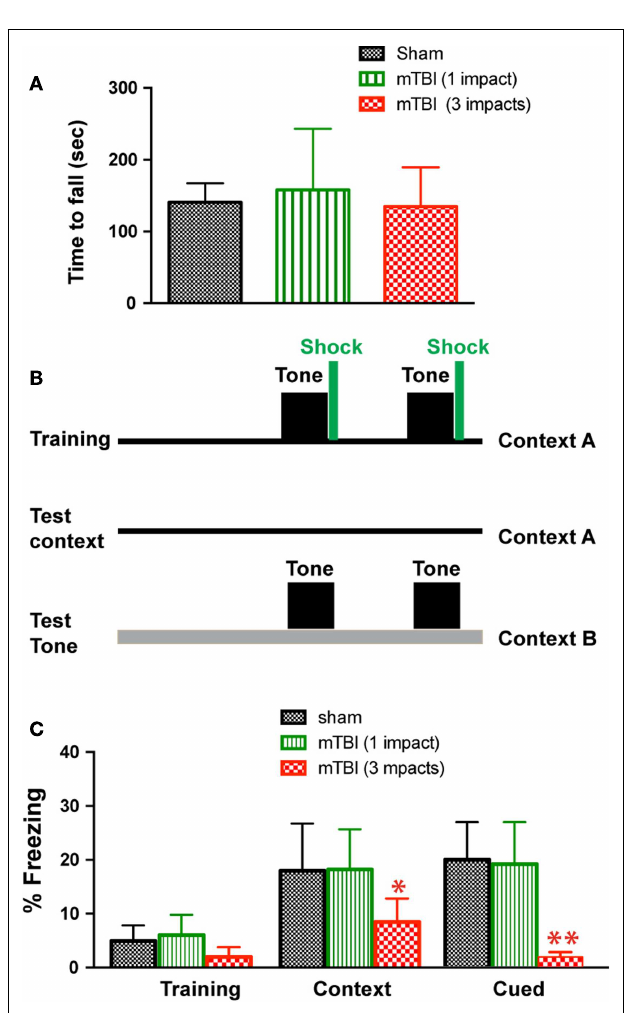
FIGURE 2 | Repetitive mTBI causes significant cognitive impairments 3months after injury .Three months after injury, the GFAP-luc mice shown in Figure 1E were tested for motor function using a Rota-Rod apparatus (A) and for learning and memory using fear conditioning (B,C) . (A) In the Rota-Rod test, latency to fall onto the transducer platform was automatically recorded.The average latency over the three trials was calculated for each mouse. No difference between the mTBI and sham groups were observed (mean ± SD, P > 0.05 by t test). (B) The test paradigm for fear conditioning. (C) The freezing behavior was recorded and analyzed. Mice exposed to mTBI (three impacts) showed reduced baseline freezing behavior, and context- and cue-related freezing behavior. n = 5 mice/group. Mean ± SD; * P < 0.05, ** P < 0.01; ANOVA and Bonferroni